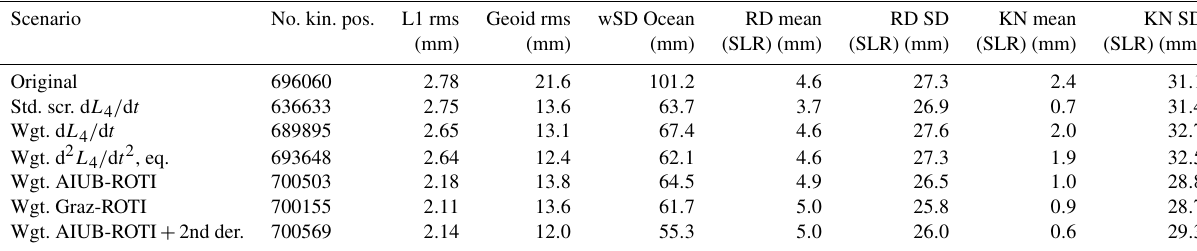
Table 1. Statistics and SLR residuals for Swarm A, March 2015. Scenario